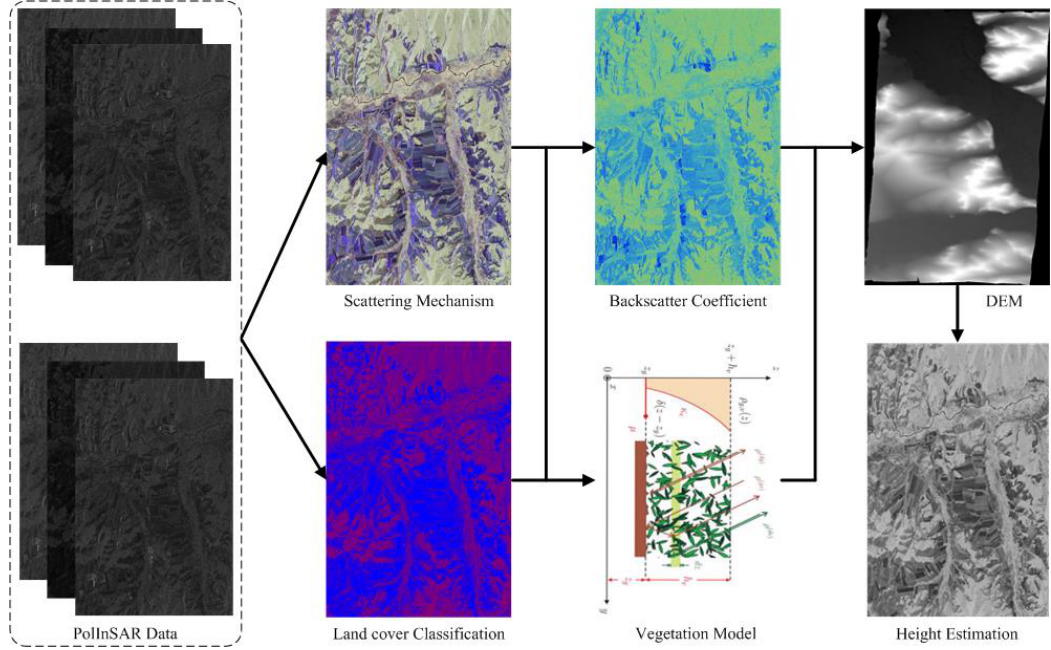
Figure 4. Framework of terrain correction and species diversity based vegetation vertical structure